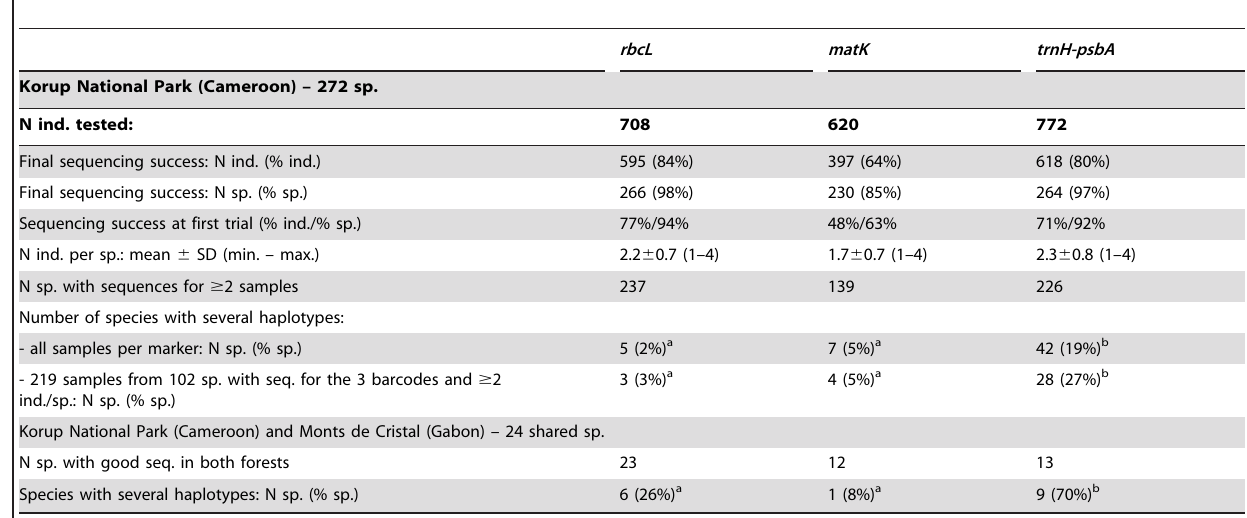
Table 1. Sequencing success and intra-specific sequence polymorphism of trees from two African rain forests for rbcL , matK and trnH-psbA